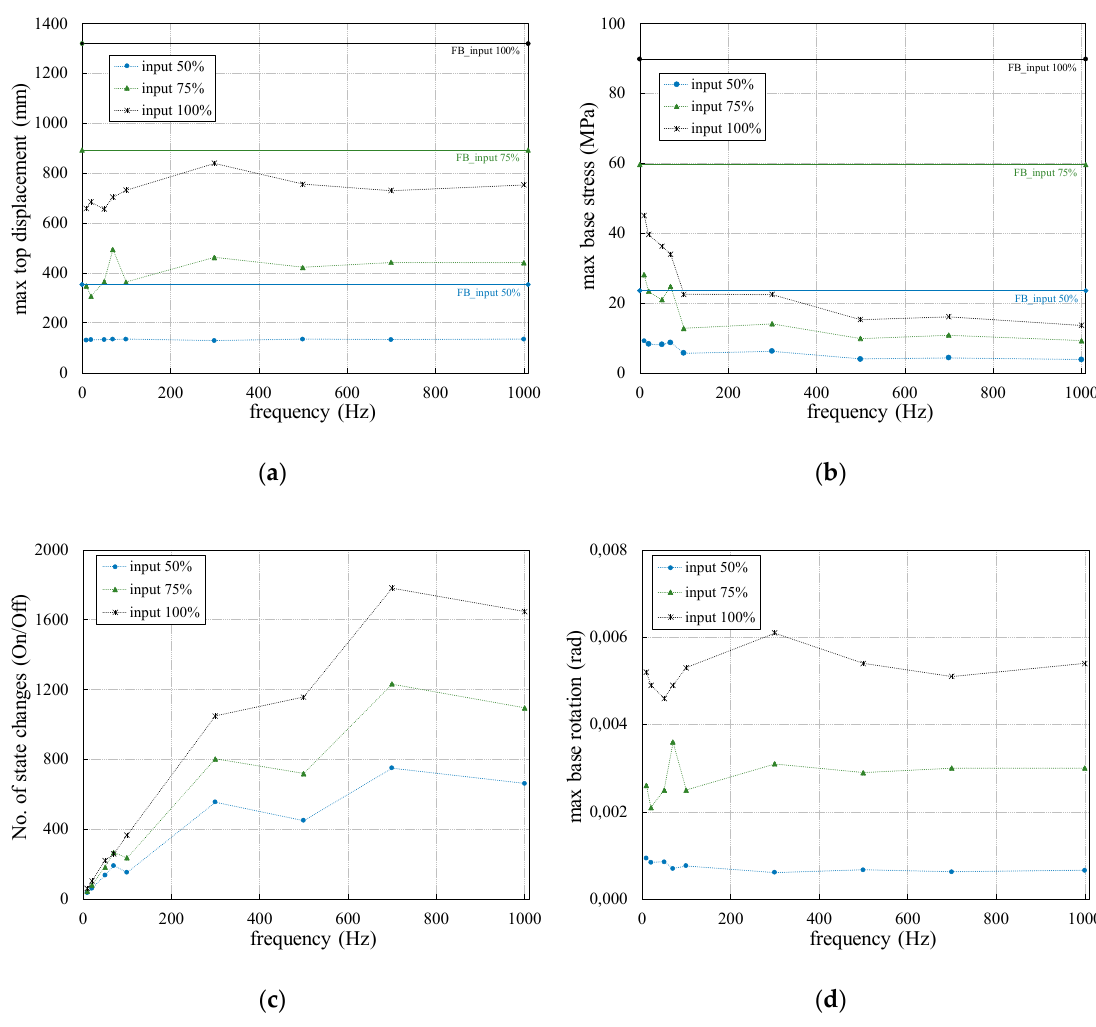
Figure 7. Response of the wind turbine for different frequencies of measurements: peak top displacement ( a ), peak base stress ( b ), No. of state changes ( c ), peak base rotation ( d ). Table 4. Range of demand reduction against the three load cases for the range 10-1000 Hz of SA control frequency.